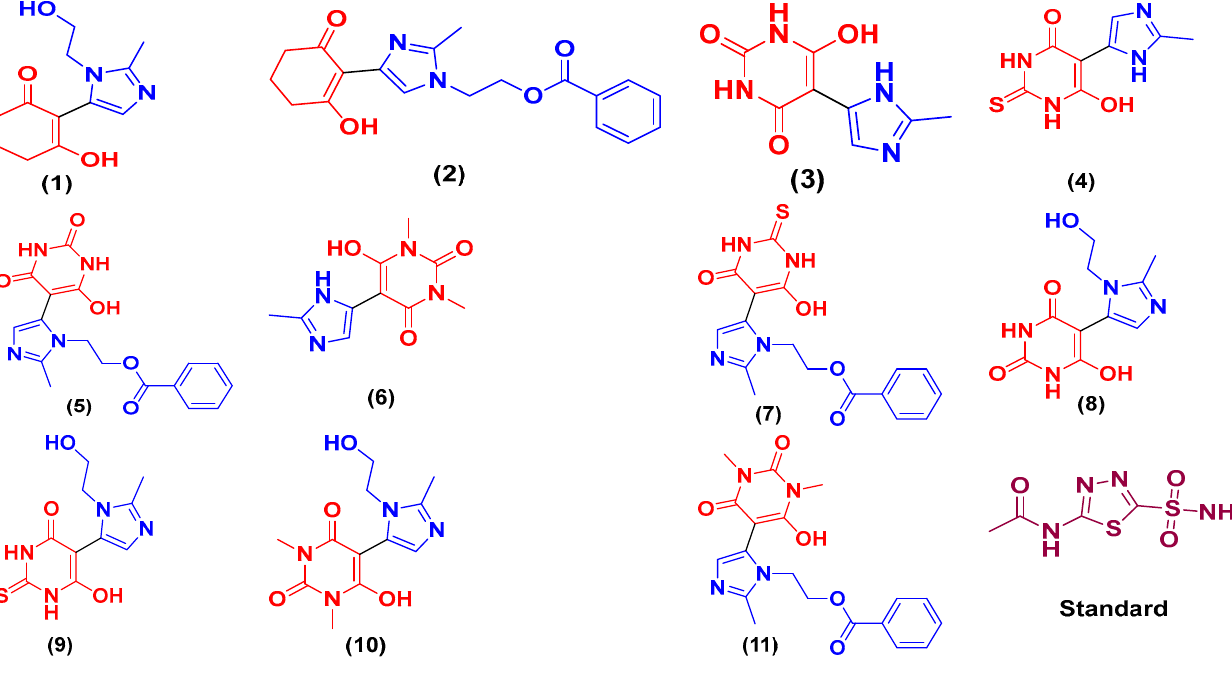
Scheme 1. The water-based green reaction under microwave condition.